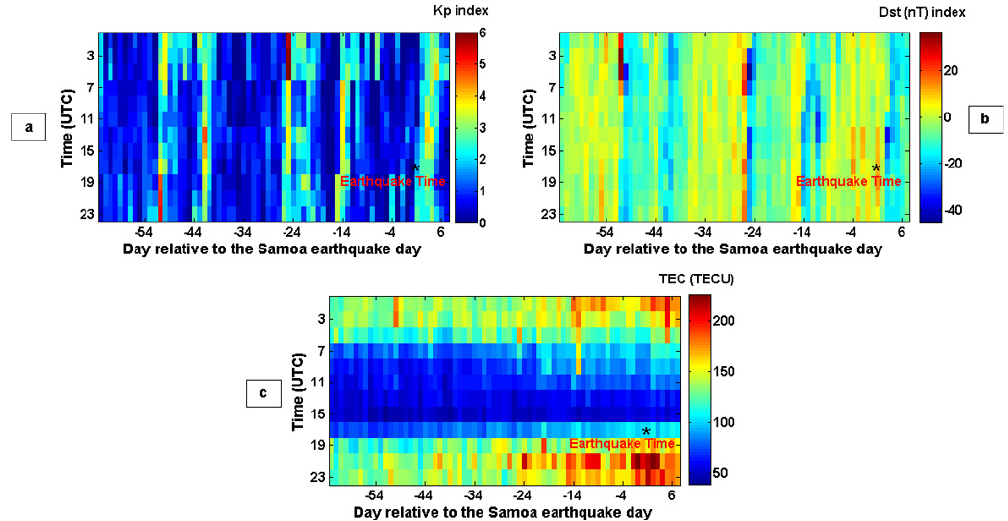
Fig. 12. Data of the one year before the Samoa earthquake showing variations of (a) Kp geomagnetic index, (b) Dst geomagnetic index and (c)